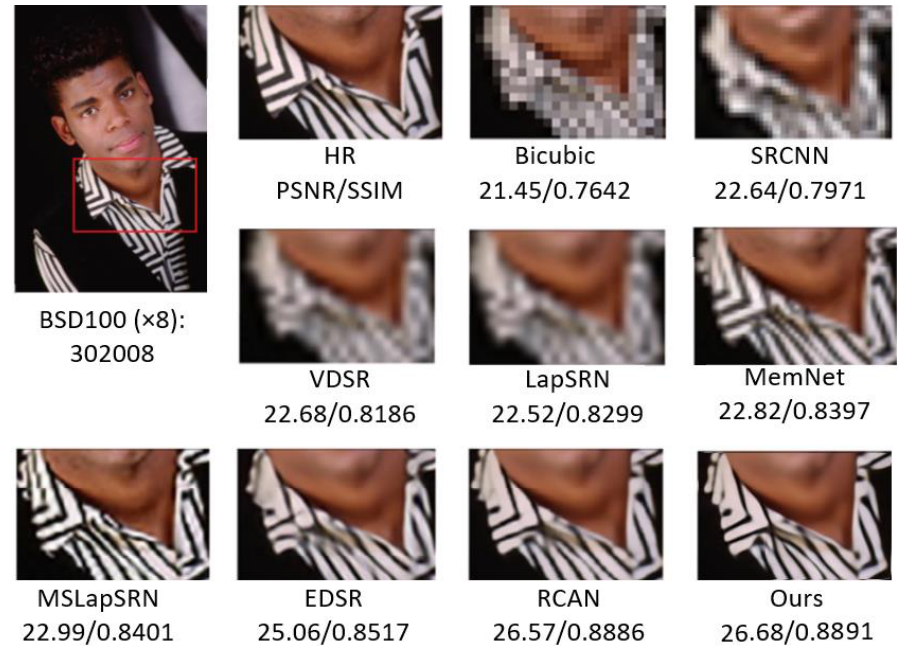
Figure 14. Visual comparison of image “302008” at × 8 scale on the BSD100 dataset.